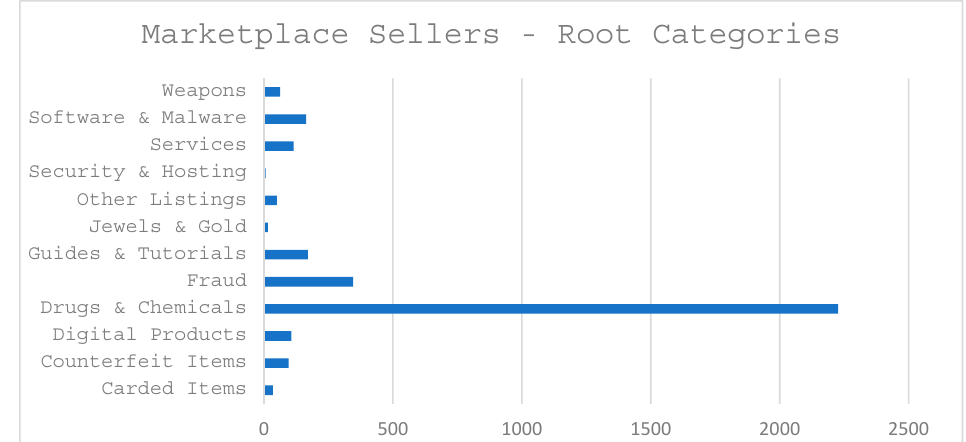
Figure 7. Marketplace Sellers—Root Categories.